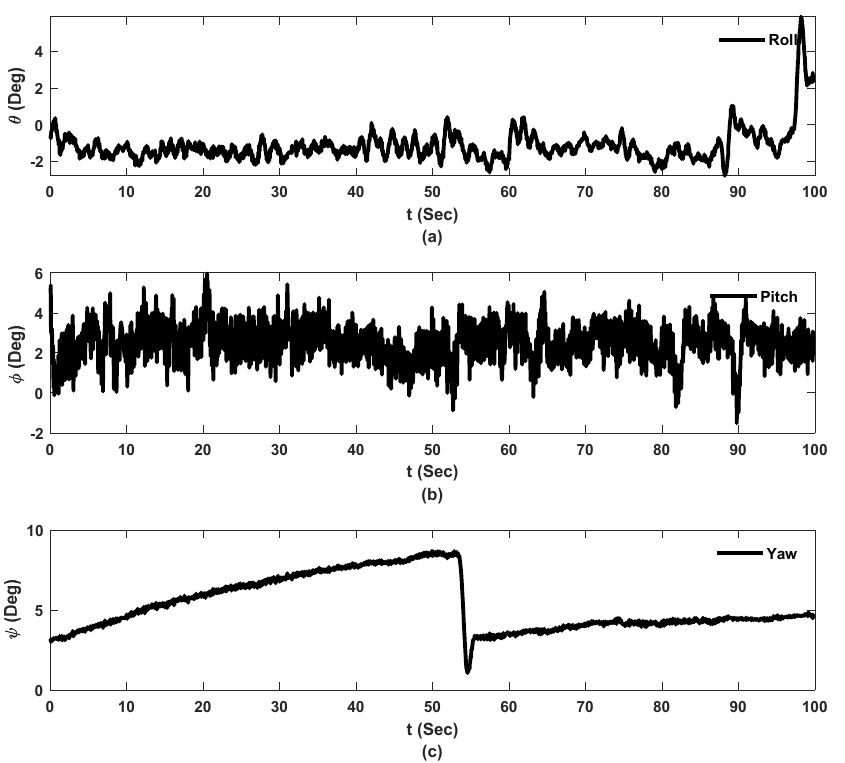
Figure 9. Translational motion of the UAS tracked by camera, experiment 2: ( a ) X direction of the camera; ( b ) Y direction of the camera corresponds to direction of interest (toward bridge); ( c ) Z direction of the camera.